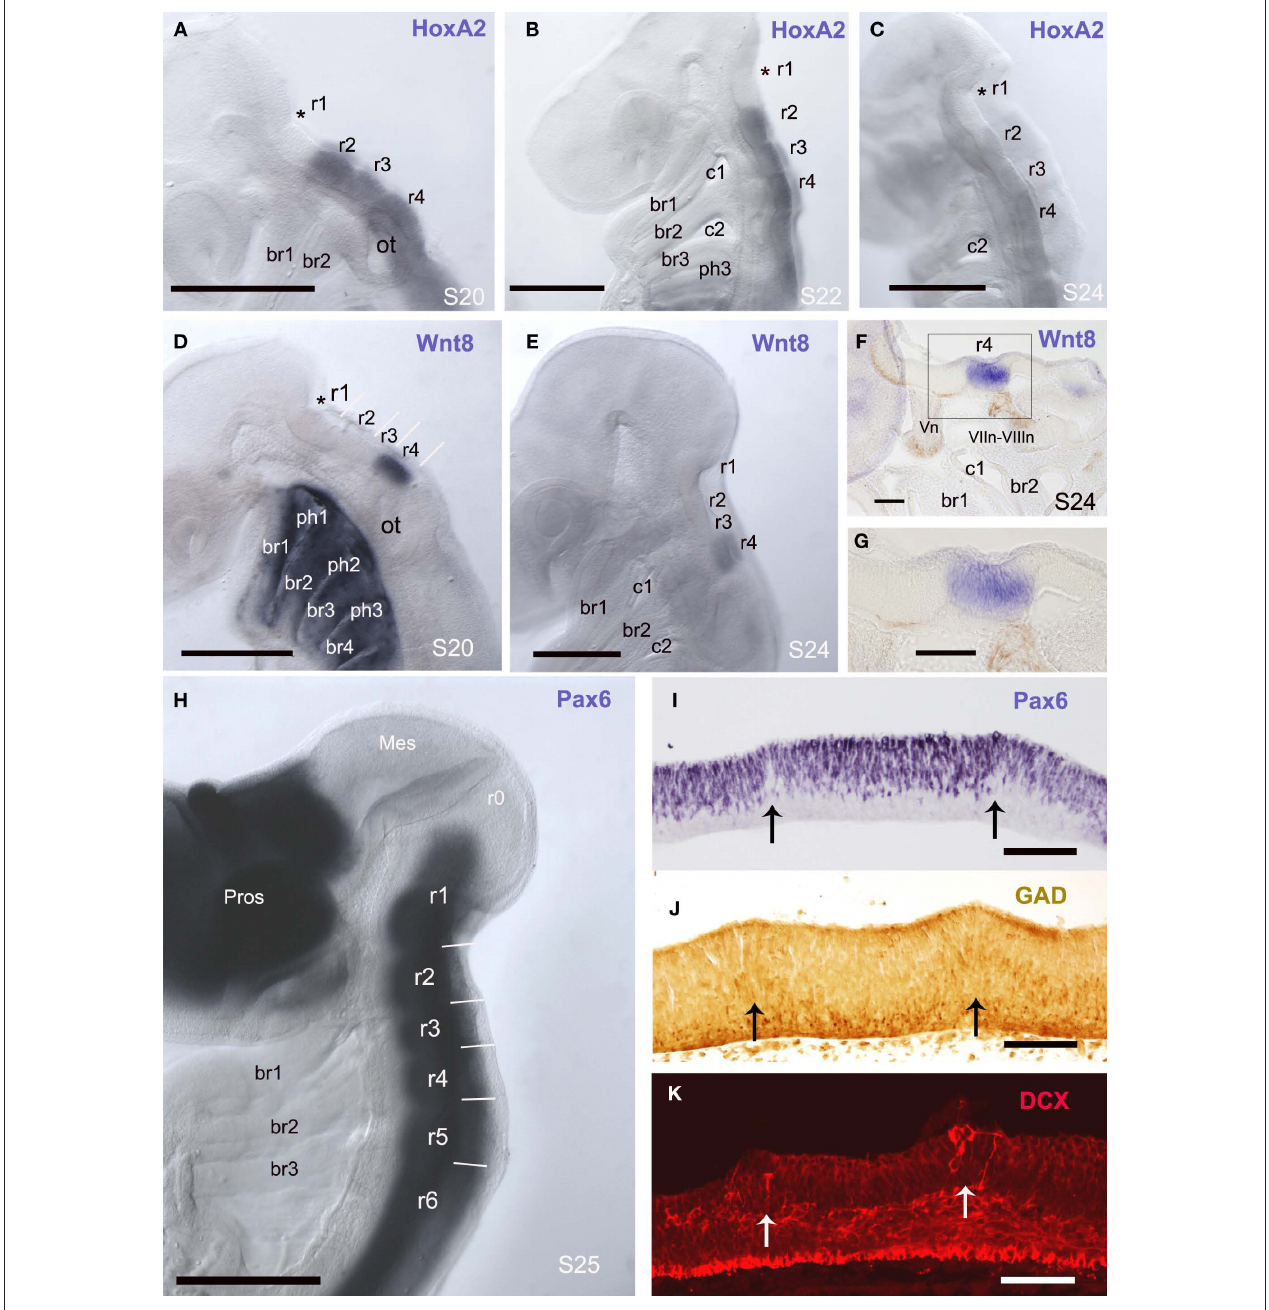
processed for in situ hybridization showing ScWnt8 expression in r4 (in blue) where DCX-immunoreactive fibers of the acoustic-facial nerve roots emerge. (i–K) Parasagittal sections immunolabeled for Pax6 (i) , GAD (J) , and DCX (K) showing ventricular ridges that coincide with interrhombomeric limits.